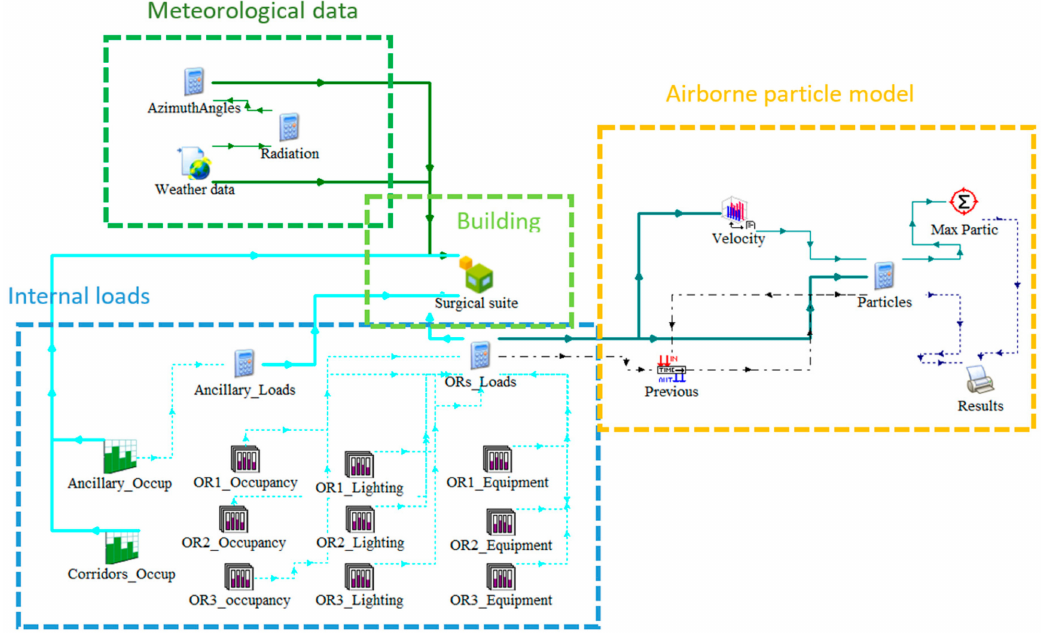
Figure 4. Simulation diagram implemented in